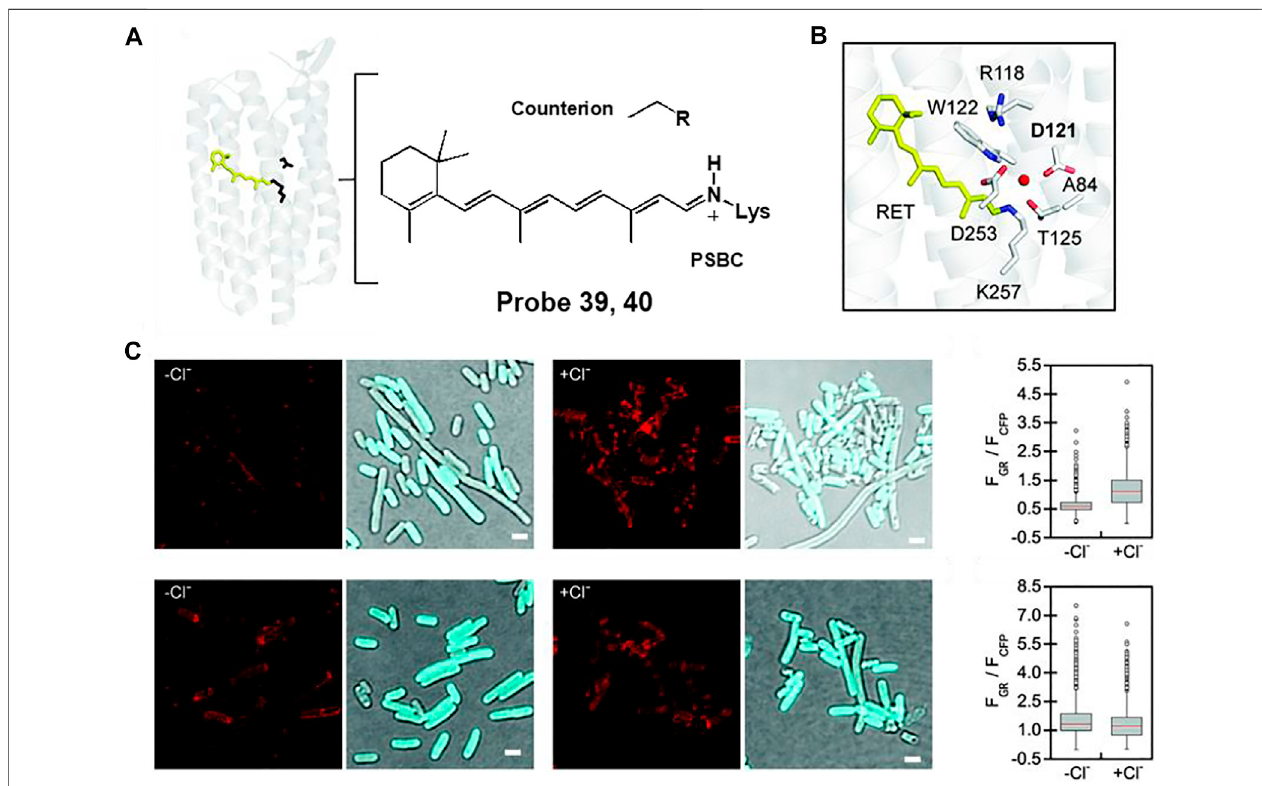
FIGURE20 |(A) Chemical structureof rhodopsin. (B) The fl uorescent proton pumpingrhodopsin from Gloeobacter violaceus (wtGR). (C) Fluorescence images of probes 39 (top) and 40 (bottom) in the absence and presence of chloride ion. Reproduced with permission from Tutol et al. (2021). Copyright © 2021, Royal Society of